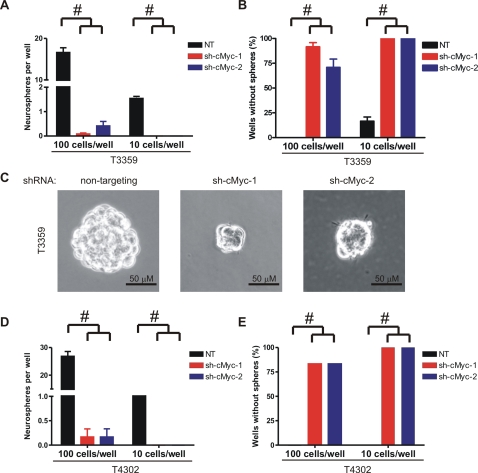
Depletion of c-Myc attenuates neurosphere formation by glioma cancer stem cells.(A) T3359 CD133+ cells were infected with lentivirus and selected as described. Cells were then plated at 100 or 10 cells per well in 24-well plates in the presence of 1 µg/ml puromycin. Eight wells were plated for each group. The numbers of neurospheres in each well were determined in seven days. Spheres that contained more than 20 cells were scored. (B) Percentage of wells without neurospheres formed was quantified. #, p<0.001 with one-way ANOVA comparison of the control groups to the corresponding c-Myc knockdown groups. (C) Representative photographs of neurospheres formed by cells expressing non-targeting shRNA or c-Myc specific shRNA (bars = 50 µm). (D, E) Similar results were demonstrated in T4302 CD133+ cells.